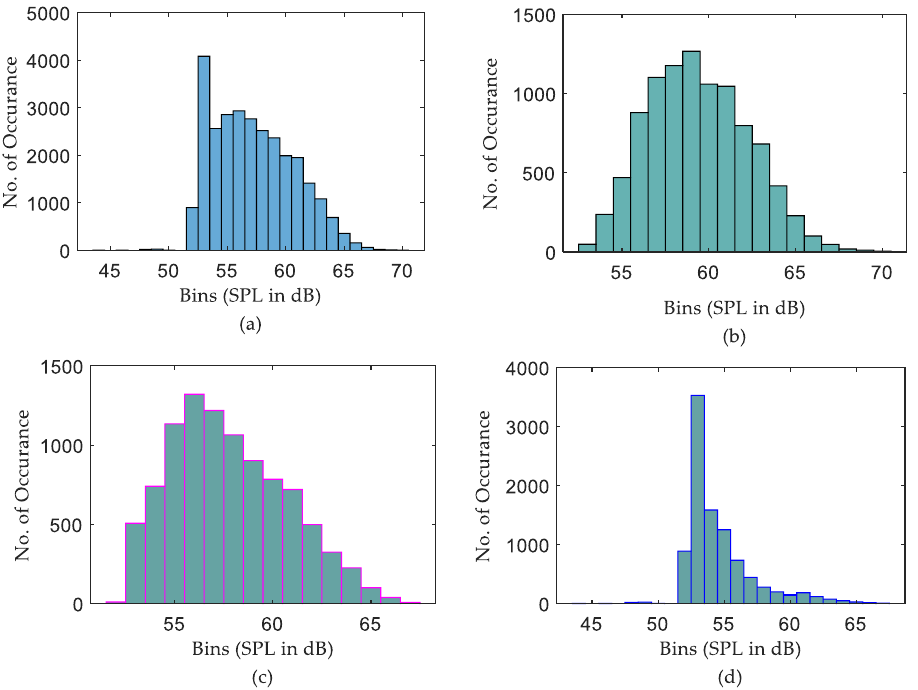
Figure 13. Histogram calculation of ICU2 data over 20 days, ( a ) distribution of SPLs over the entire period, ( b ) distribution of SPLs over daytime, ( c ) distribution of SPLs over evening, and ( d ) distribution of SPLs over night.